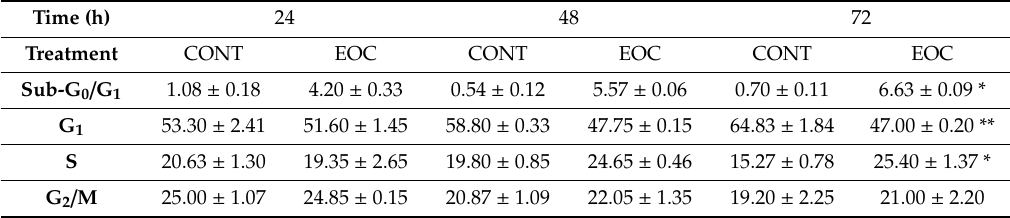
Table 5. The cell cycle distribution in MDA-MB-231 cells after EOC treatment.